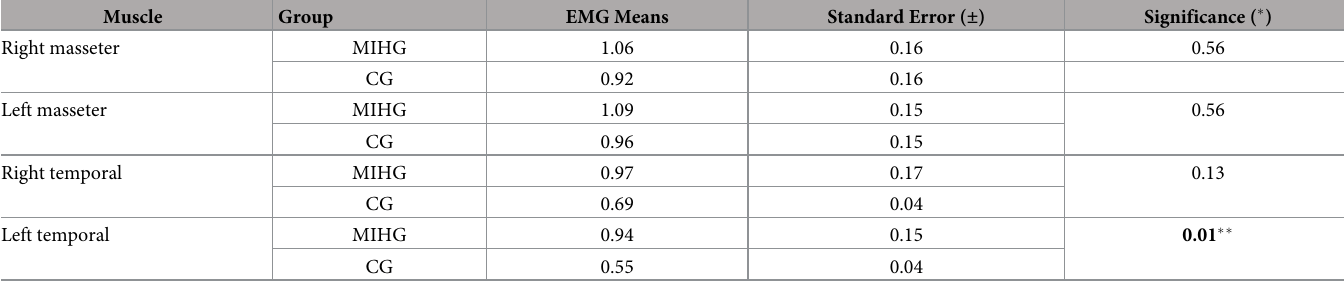
Table 7. Mean values, standard error, and statistical significance (p � 0.05) of the normalized electromyographic data in the habitual mastication of consistent food condition, for each muscle evaluated, in the MIH group (MIHG) and control group (CG). Muscle